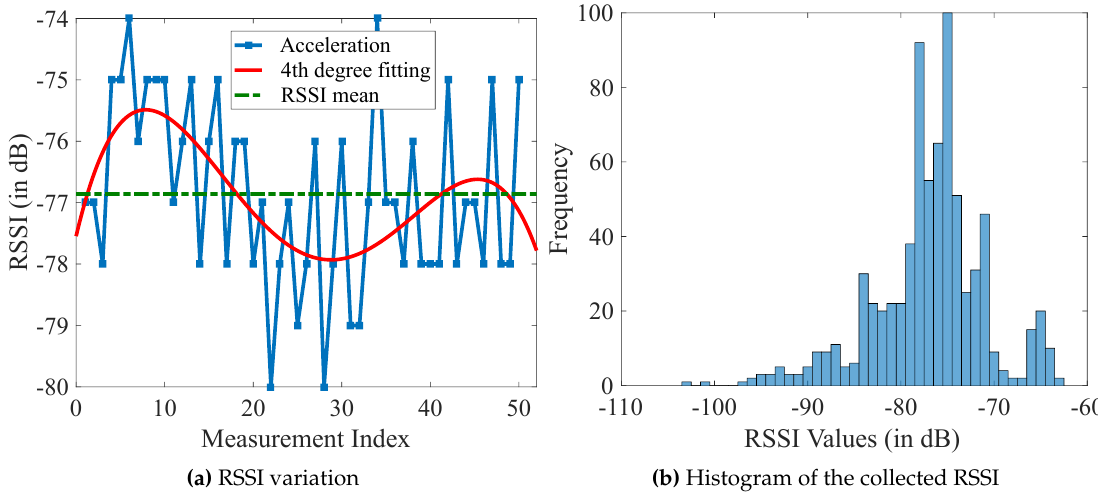
Figure 2. RSSI analysis for a BLE-based